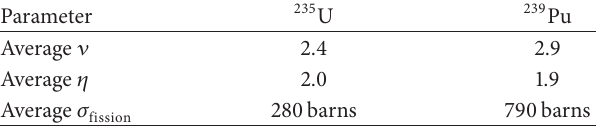
Figure 9: The neutron flux spectra of three unit cell compositions. Table 6: LWR neutronics parameters [6, Table 3–1 page